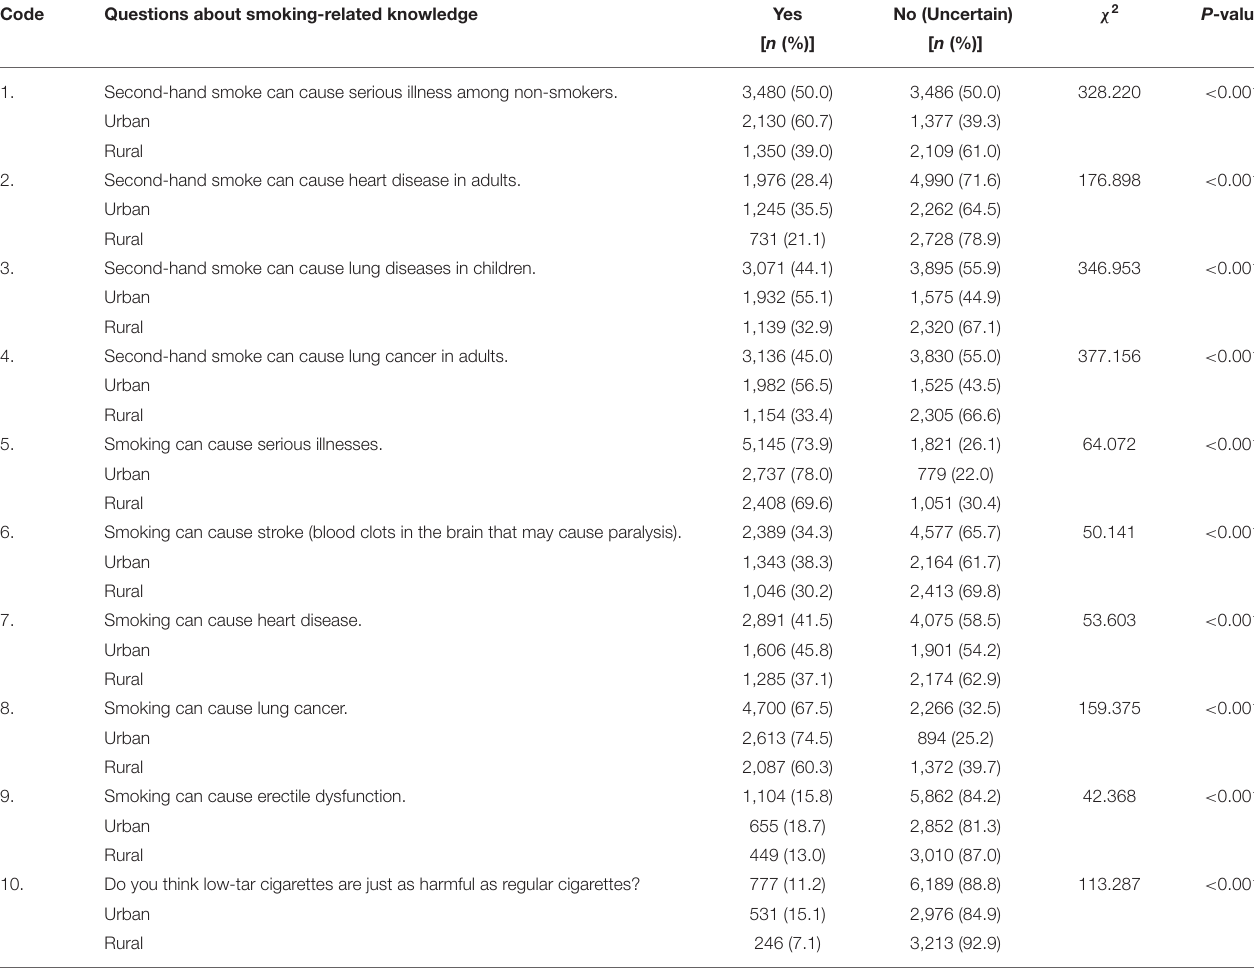
TABLE 2 | Responses to smoking-related knowledge among the urban and rural elderly. Code